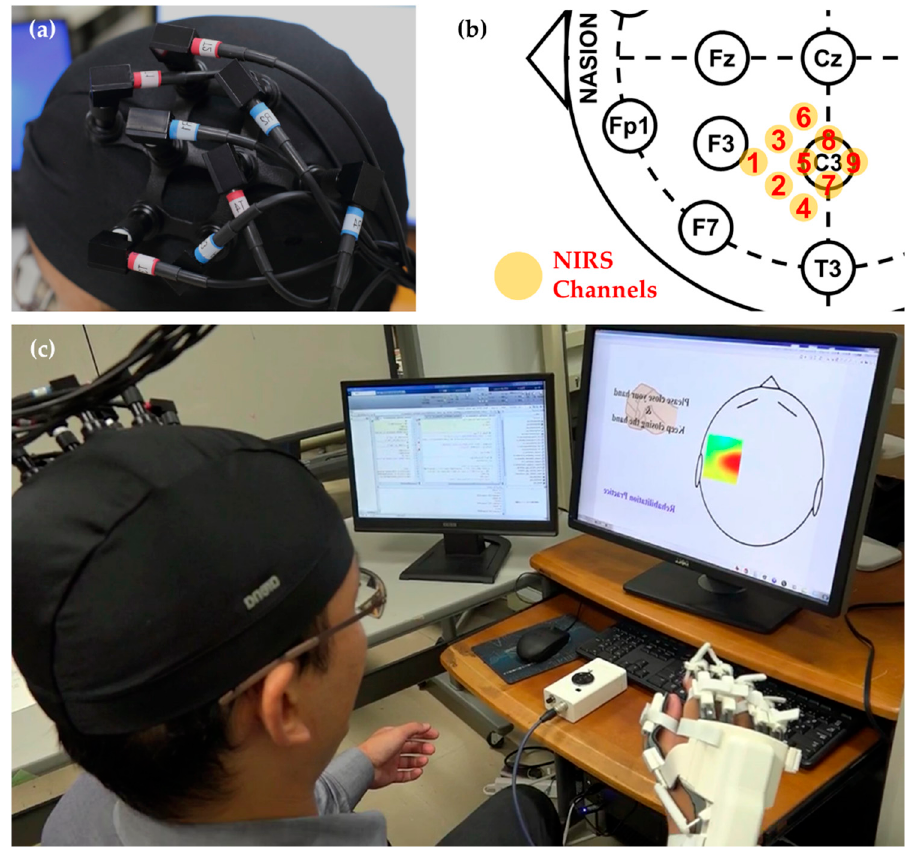
Figure 2. NIRS Channel Configuration and Experimental Setup: ( a ) The four pairs of optodes are positioned and fixed with a swimming cap. ( b ) Channels 5, 7, 8, and 9 (emitted by the emitter 4) are placed around C3. ( c ) Experimental Setup. A participant wearing the NIRS optodes and robotic hand orthosis performs the task instructed through the monitor.